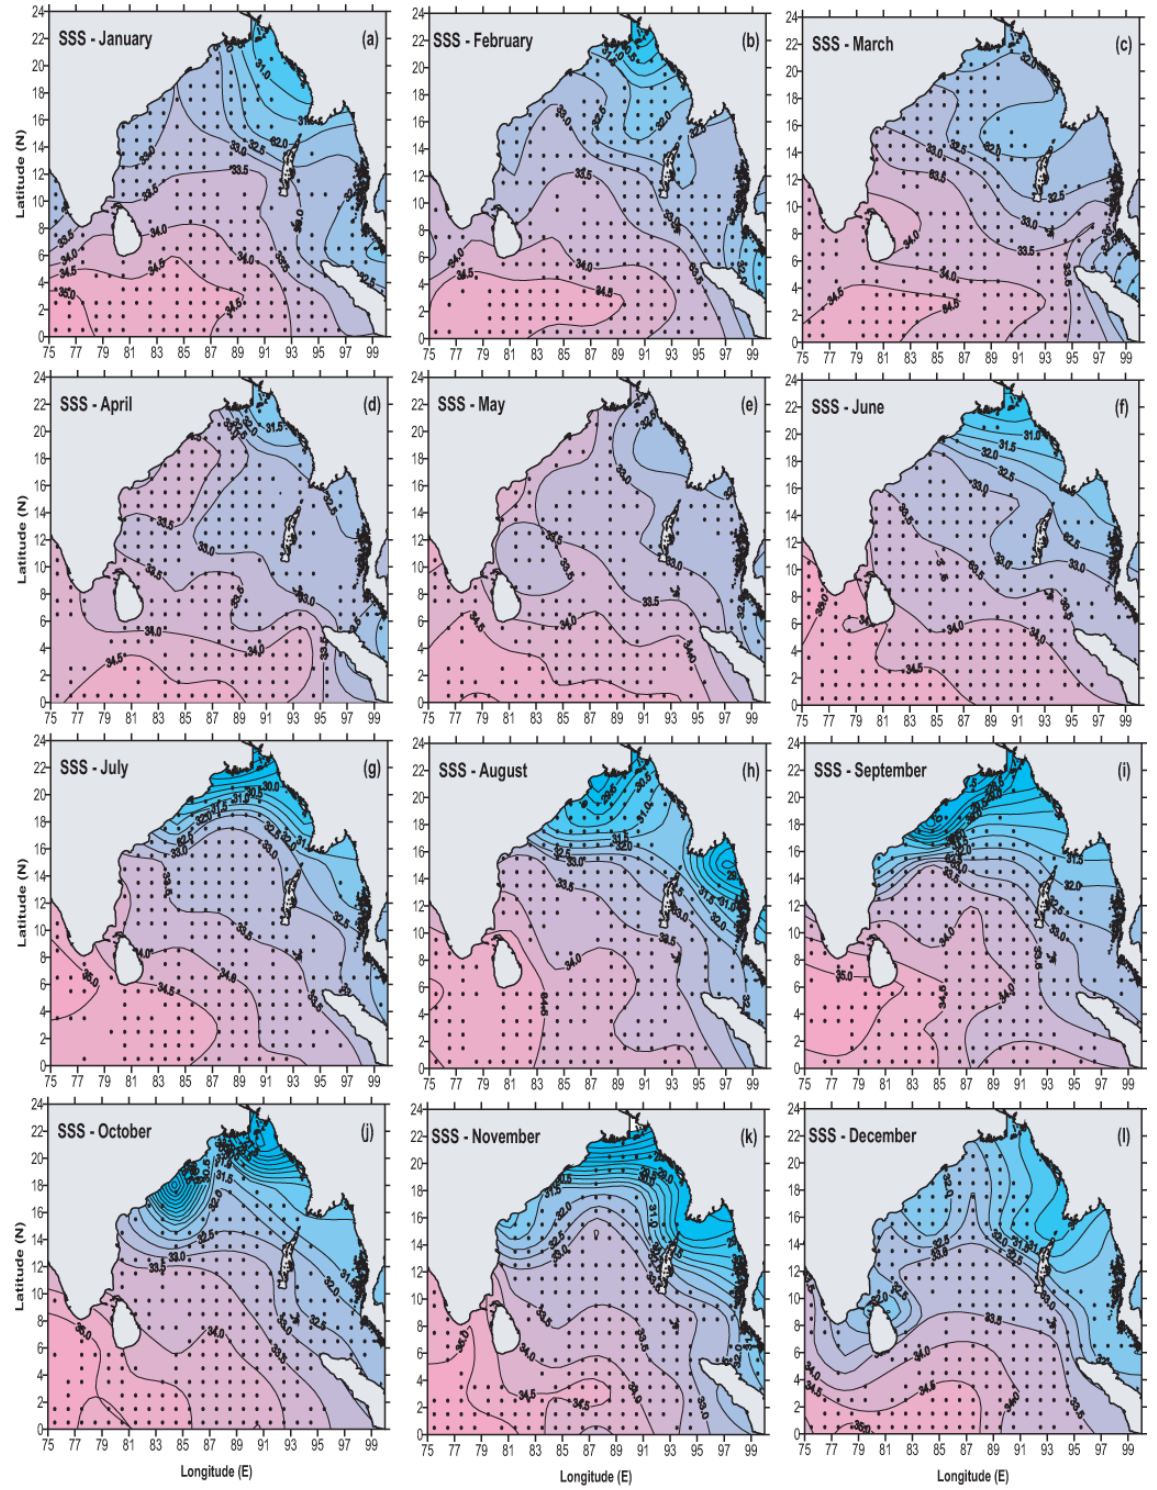
Figure A3. Monthly mean climatology of sea surface salinity (SSS, psu) from January to